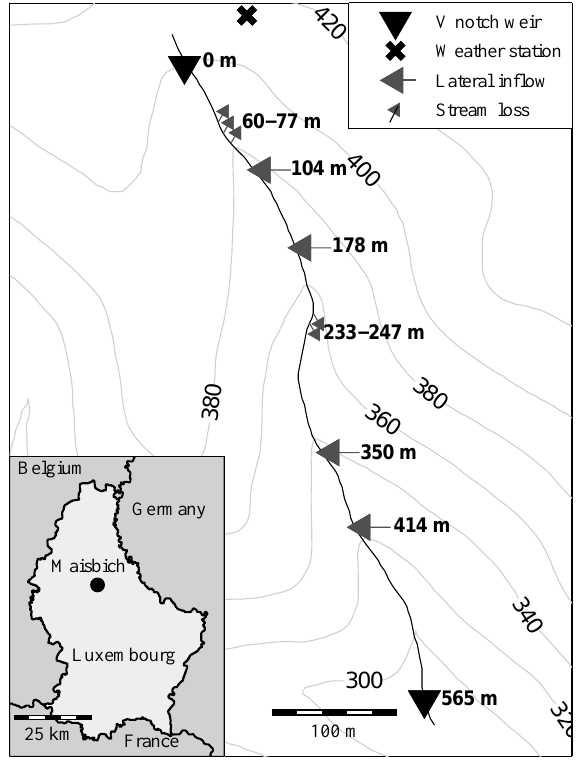
Fig. 1. Map of the studied stretch of the Maisbich. The isohypse show the altitude above mean sea level. Distances of the lateral in- and outflows are distances from the upstream V-notch weir mea- sured along the